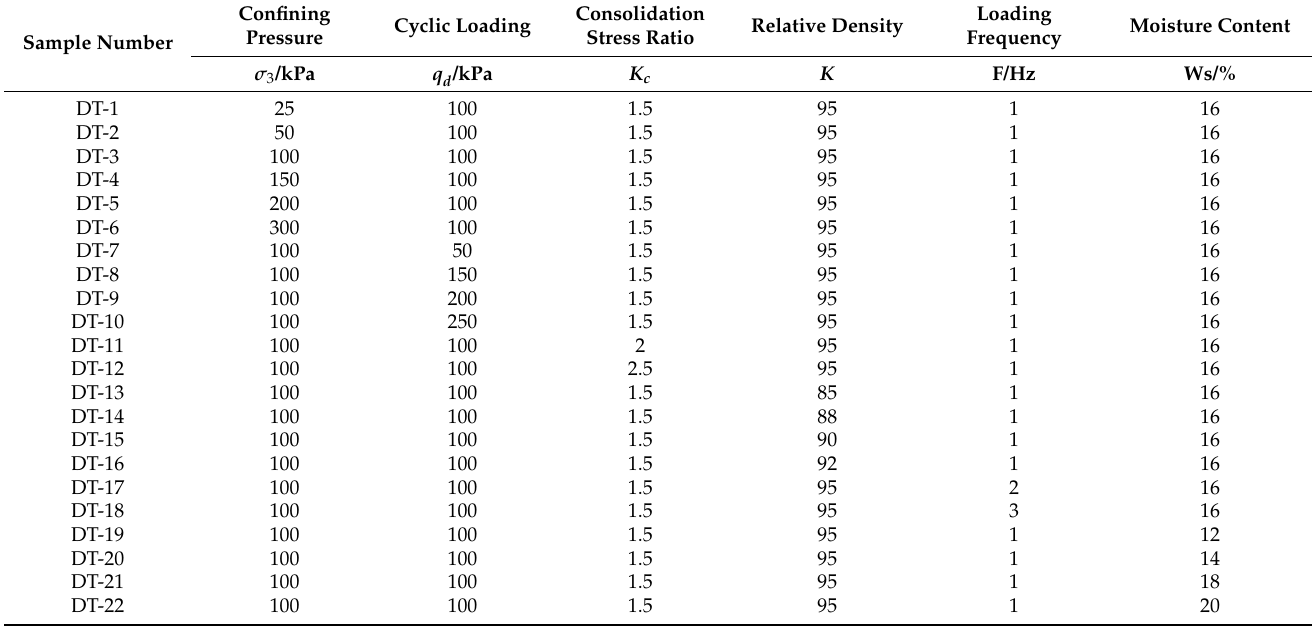
Table 1. Summary of cyclic triaxial test